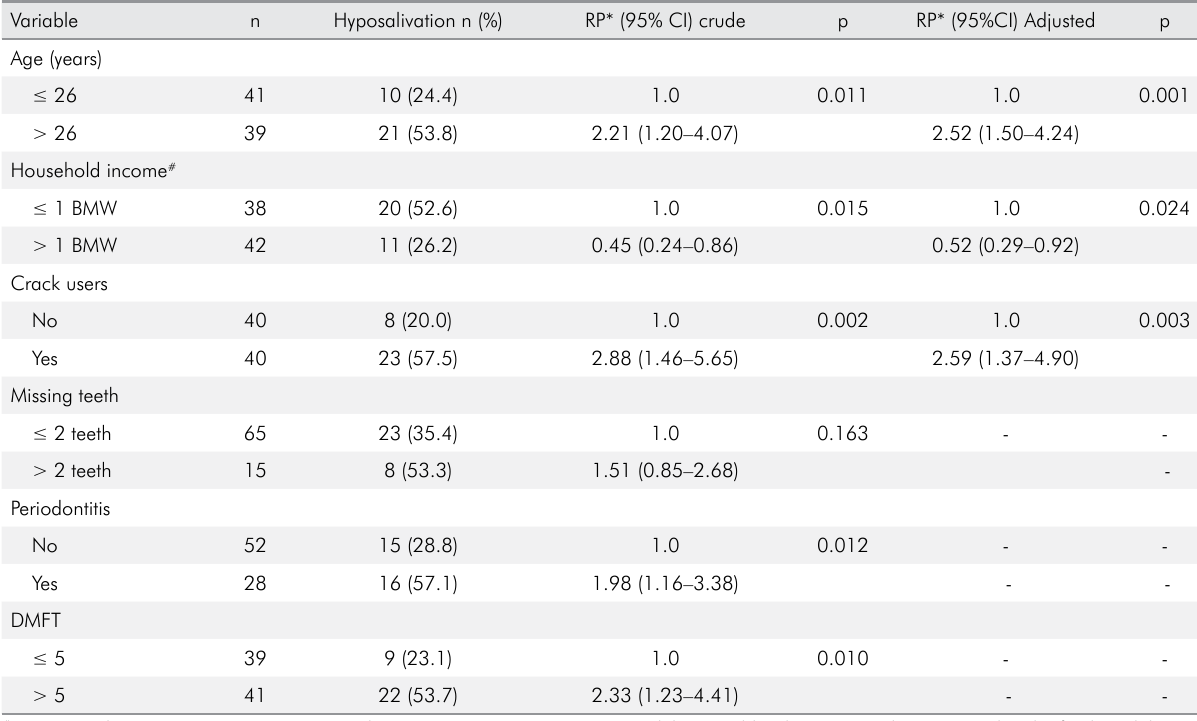
Table 3. Association between hyposalivation and demographic, behavioral, and clinical